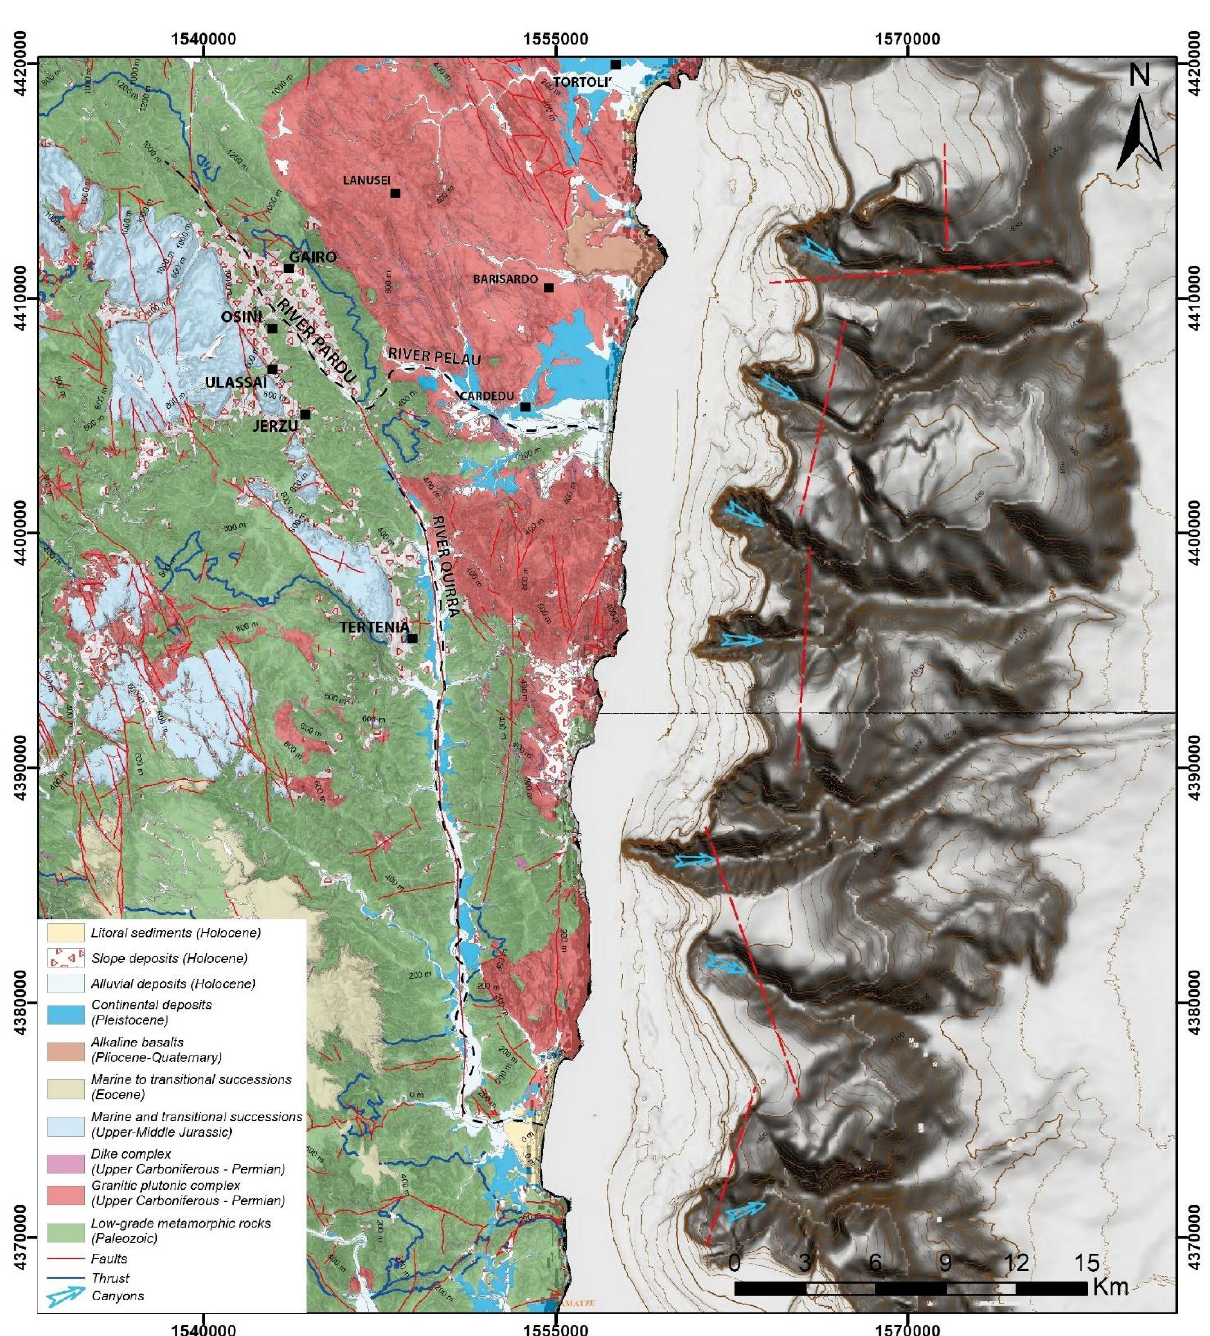
Figure 2. Geolithological sketch map of the study area based on geological data of the Autonomous Region of Sardinia. Continental margin topography by [58]. Black dashed lines show the analyzed rivers.